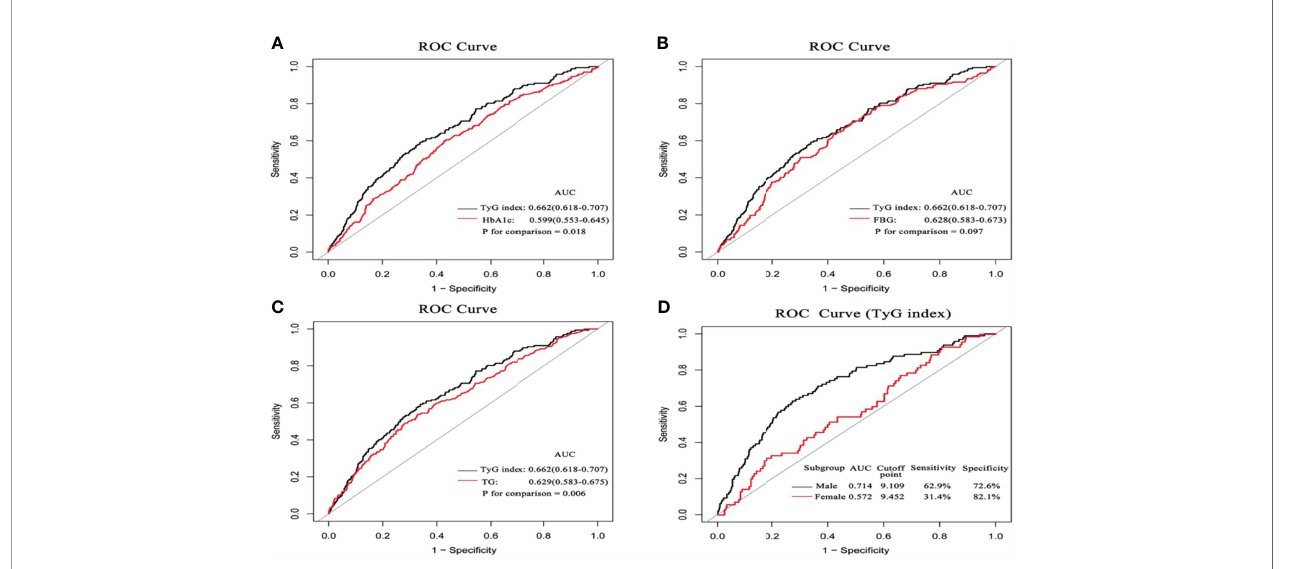
FIGURE 5 | The comparison of diagnostic performance on the incidence of CIN between HbA1c (A) FBG (B) TG, (C) , and the impact of the TyG index between the male and female subgroups (D)